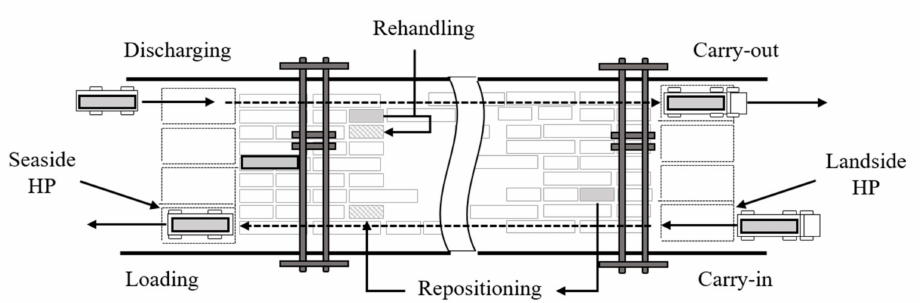
Figure 3. Structure of a storage block (adapted from